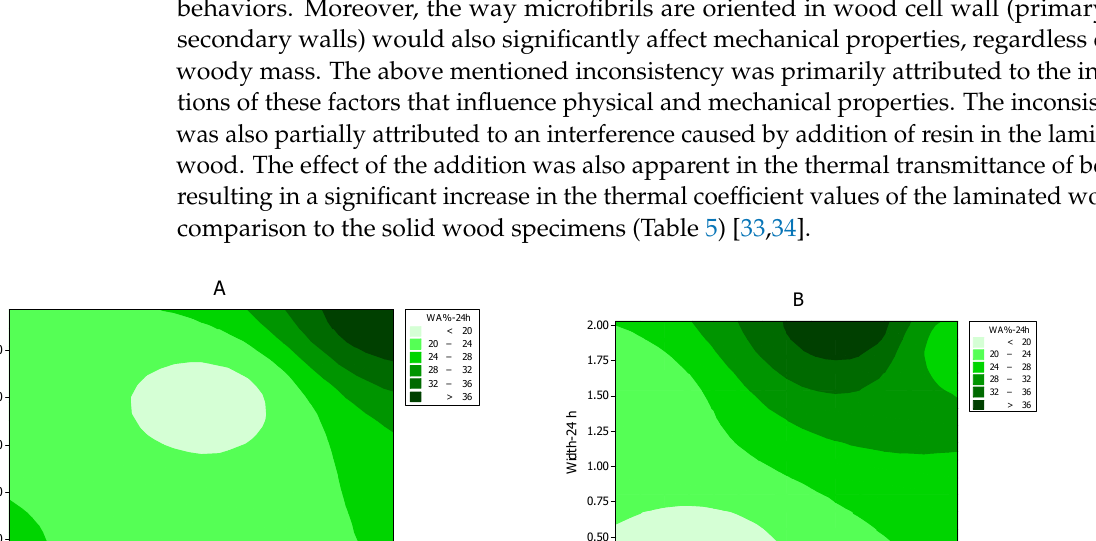
Figure 4. Contour plots between physical and mechanical properties of three-layer laminated wood made from fir and meranti wood ( A : MOR = modulus of rupture; MOE = modulus of elasticity; and B : WA = water absorption; Width and Thick-24 h = width and thickness swelling after 24 h immersion in water).